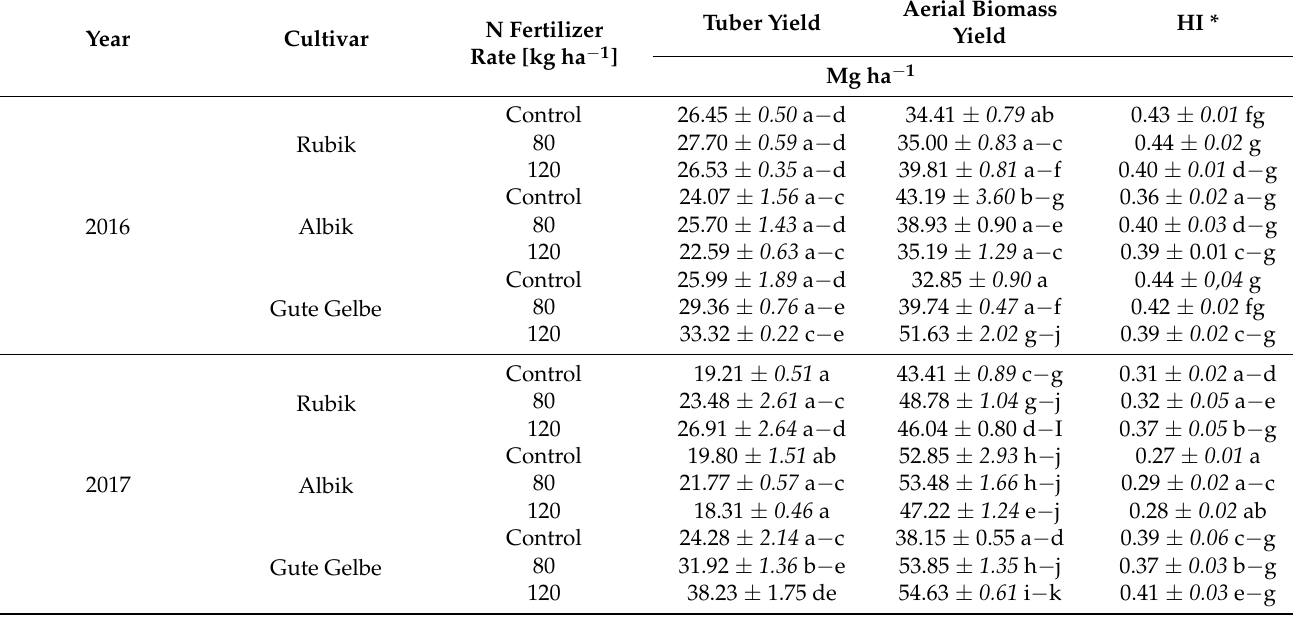
Table 4. Yields of Jerusalem artichoke tubers and aerial biomass, and the harvest index (average ± SE; tuber yields are means of two harvest dates, autumn and